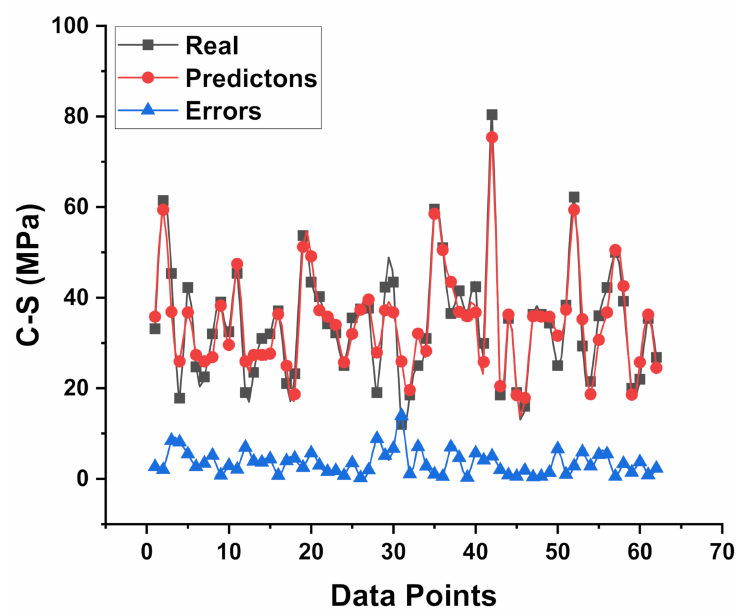
Figure 4. Experimental and predicted dispersal of the results along with the scattering of their errors for the MLP model.